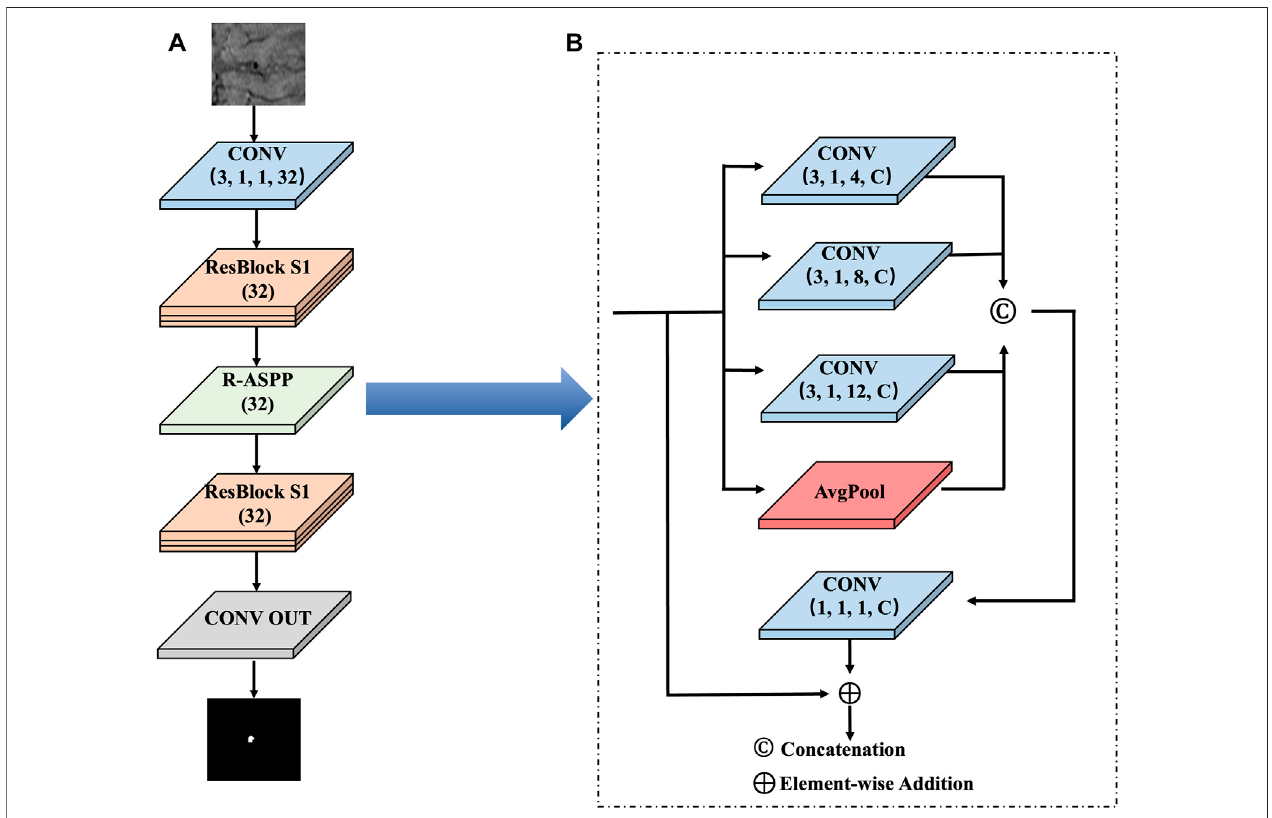
FIGURE 3 | The second stage of the network architecture. (A) FRN framework: This framework removes the downsampling structure and always extracts image features at the original input resolution to effectively prevent lesion information loss. (B) R-ASPP module: In the middle of the FRN, we innovatively add the R-ASPP